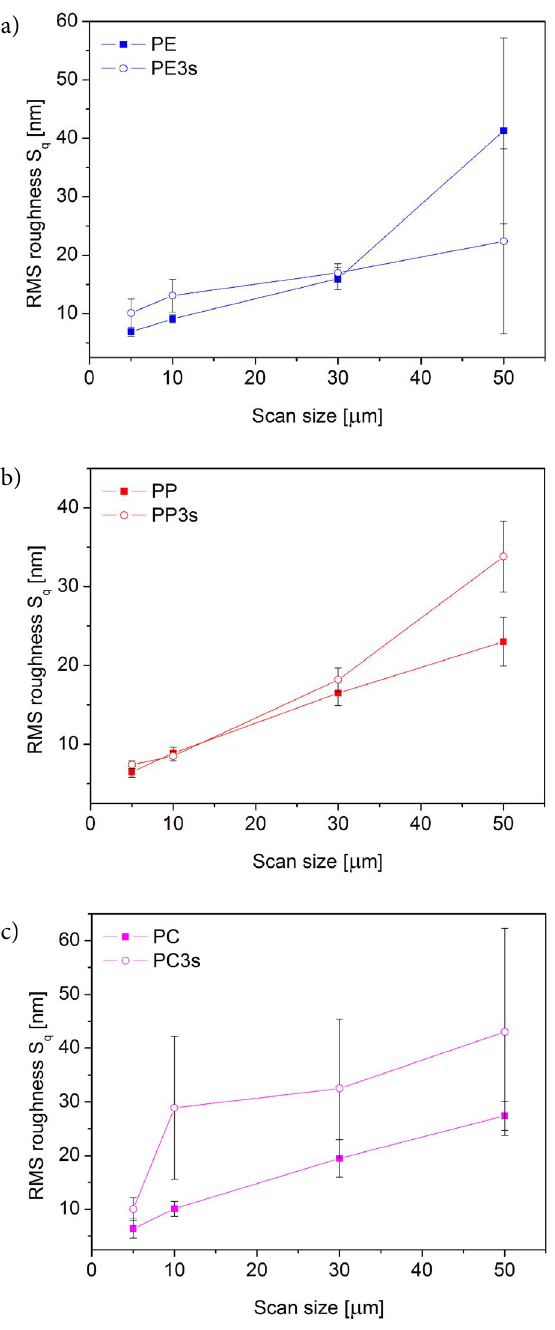
Figure 4. Oxygen contents on plasma treated a) PE, b) PP and c) PC surfaces in atomic % given by XPS. The dashed lines show the oxy- gen content of untreated polymers.